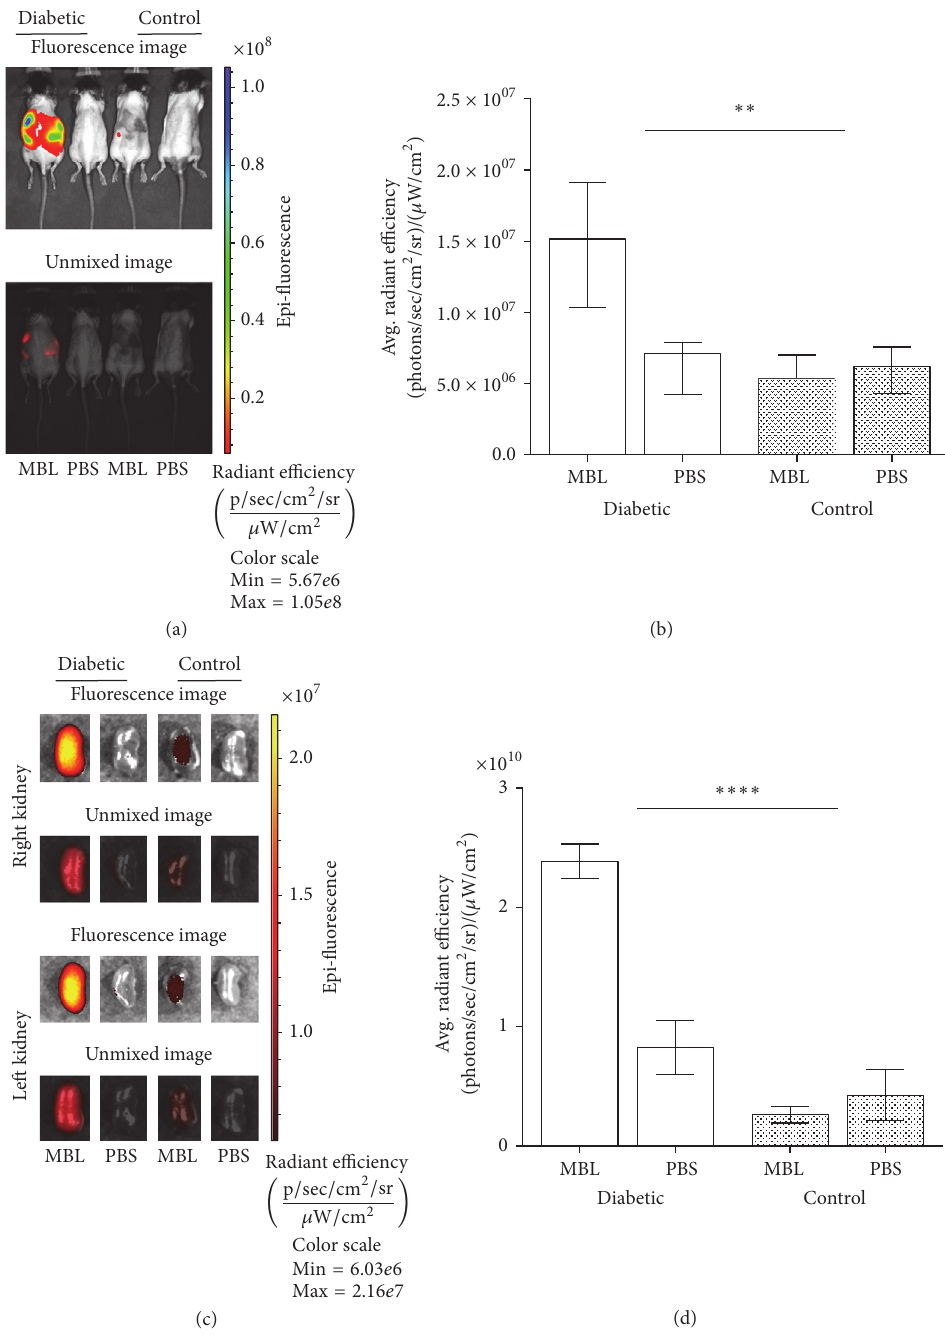
Figure 5: In vivo and ex vivo detection of AF680 labelled rMBL 24 hours postinjection. (a) Fluorescent and spectral unmixing images representing one mouse in each group exhibiting distribution of labelled rMBL 24 hours postinjection (dorsal view). (b) Region of interest (ROI) quantification of detected fluorescent signal from diabetic C57BL/6J MBL/DKO mice + AF680 rMBL ( 𝑛 = 6 ), diabetic mice + PBS ( 𝑛 = 6 ), nondiabetic mice + AF680 rMBL ( 𝑛 = 6 ), and nondiabetic mice + PBS ( 𝑛 = 6 ) given in average radiant efficiency. (c) Ex vivo fluorescent and spectral unmixing images representation of the left and right kidneys from one mouse in each group. (d) ROI quantification of detected fluorescence in the right and left kidneys of mice in each group as in (b) with values given in average radiant efficiency. Scale bars are given in radiant efficiency. Statistical tests are indicated in the figure when significant ( ∗∗ 𝑝 < 0.001 , ∗∗∗∗ 𝑝 < 0.0001 ). The experiment was repeated five times with comparable